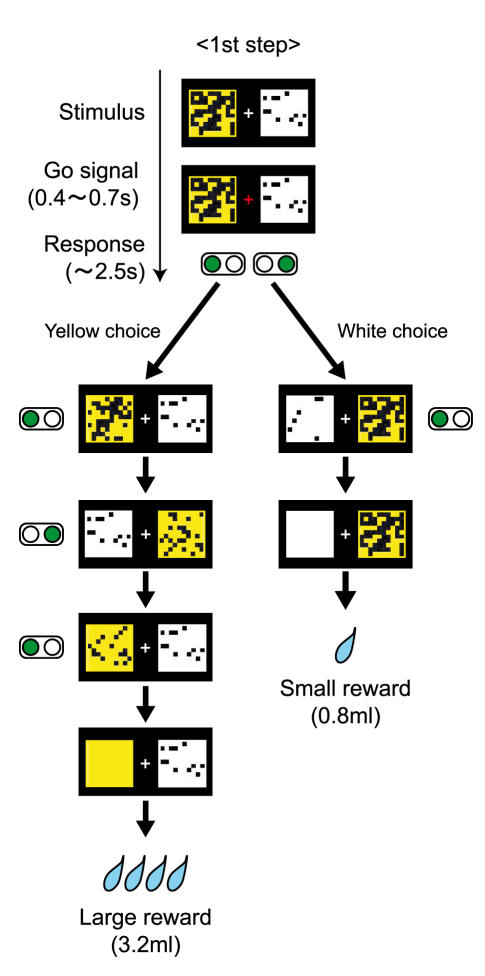
Experimental task.A subject was asked to select either a white or yellow square by pressing a button on the corresponding side. In the example shown here, if the subject chooses a white square at each step, a small amount of juice (0.8 ml) is delivered in two steps (2.5×2 = 5 sec). If the subject chooses a yellow square, four yellow choices (2.5×4 = 10 sec) must be repeated to obtain a larger amount of juice (3.2 ml). The position of the squares (left or right) was changed randomly at each step.